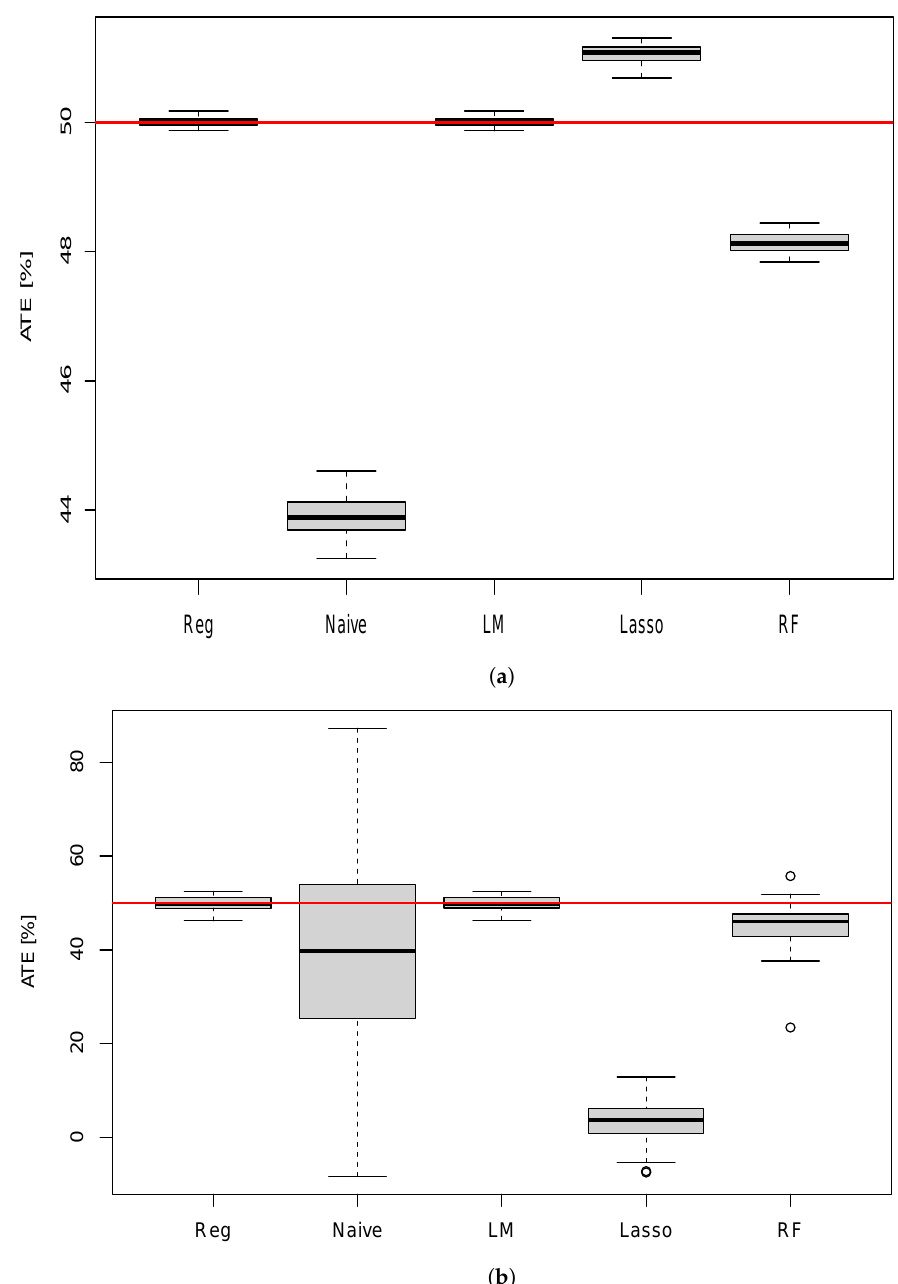
Figure 3. Box plots of the ATE estimations for the five methods where ATE true = 50. ( a ) linear. ( b )